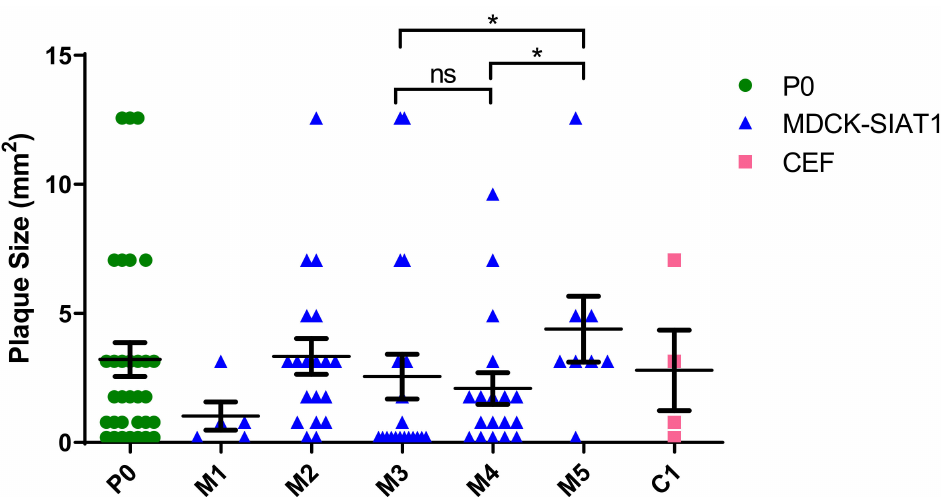
Figure 4. Mean virus plaque sizes (calculated as plaque areas) observed at each passage. The data represent mean values derived from virus plaque assays performed in duplicate. The unpaired Mann– Whitney U test was used for statistical analysis. * denotes p < 0.05 (significant); ns: non-significant. More details on the viral plaque sizes of the various virus passages are available in Supplementary File